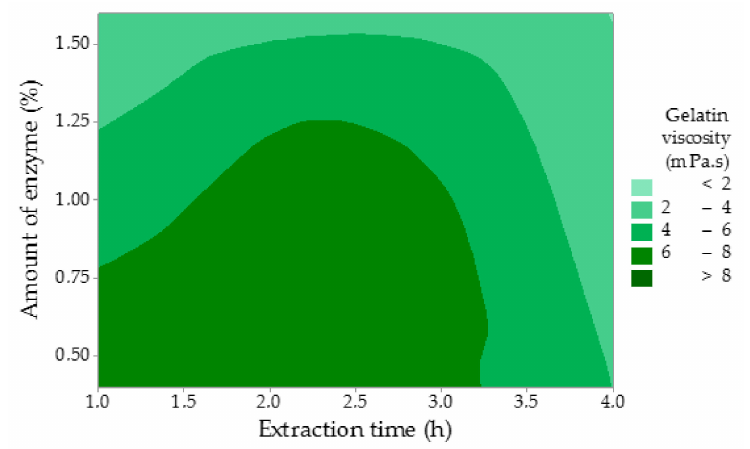
Figure 4. The influence of the time of extraction and the amount of the enzyme on the gelatin gel